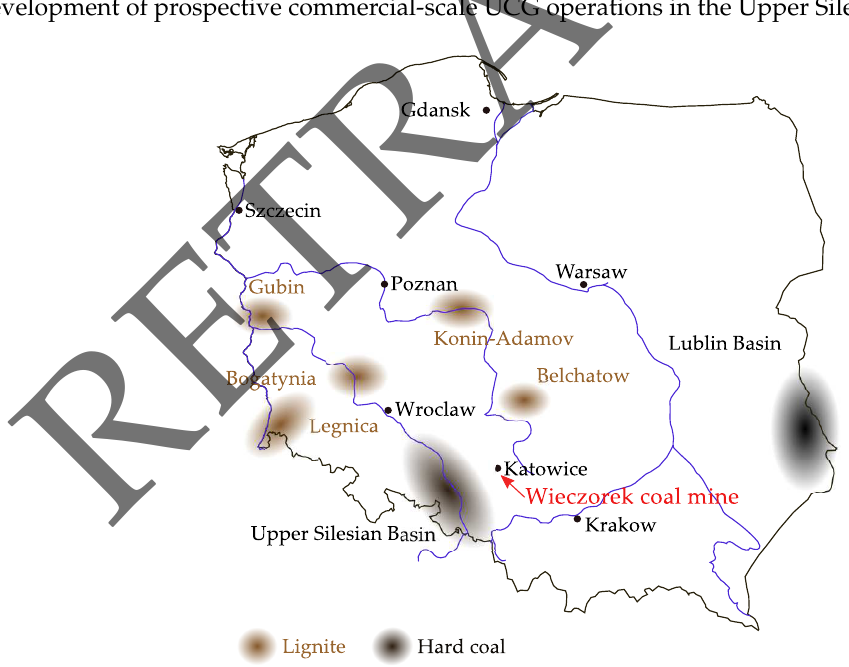
Figure 2. Location of the selected study area (Wiezcorek coal mine) in Poland. Modified according to European Association for Coal and Lignite